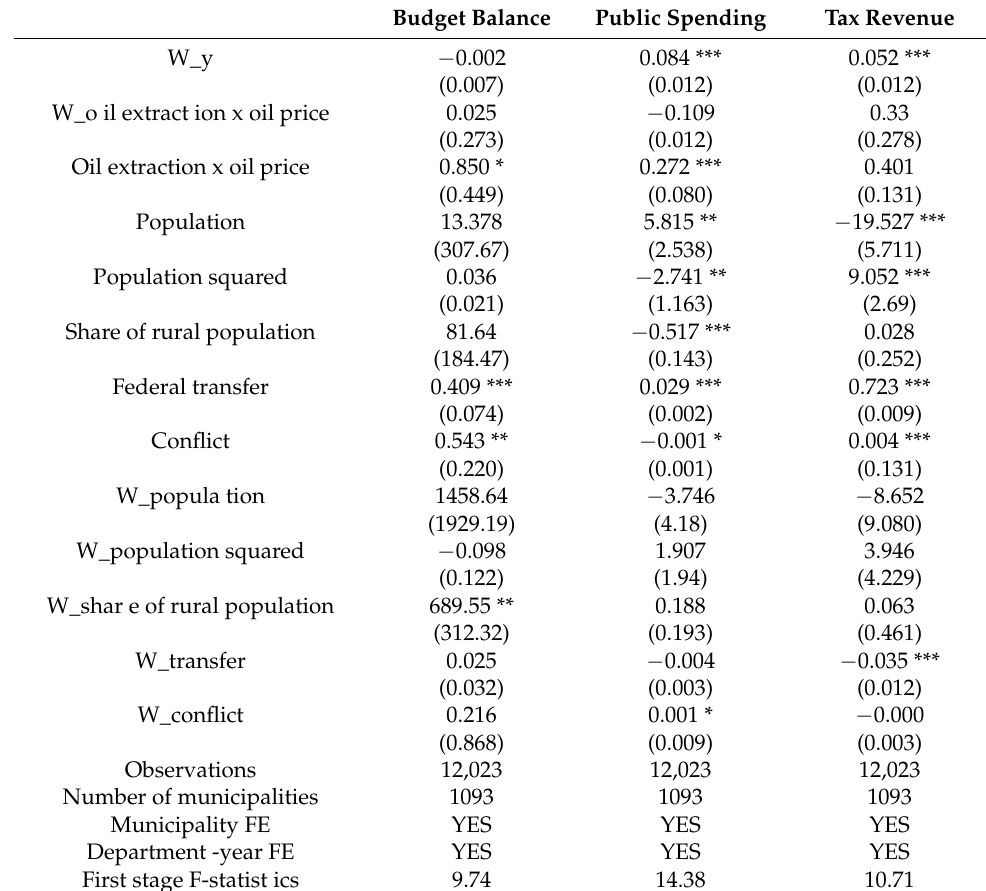
Table 5. QML results for fiscal